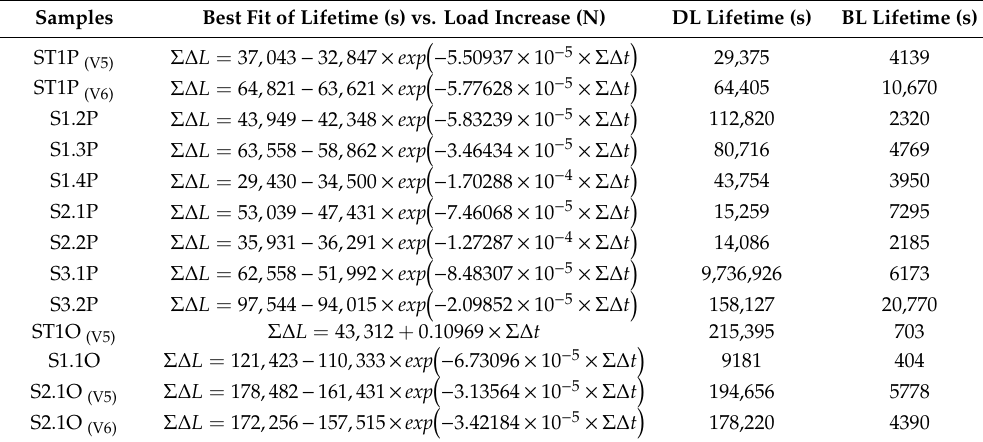
Table A2. Total expected lifetime for the ductile and brittle state for the simil-CT oak and pine samples and the best fit of lifetime versus load increase (DL fracture